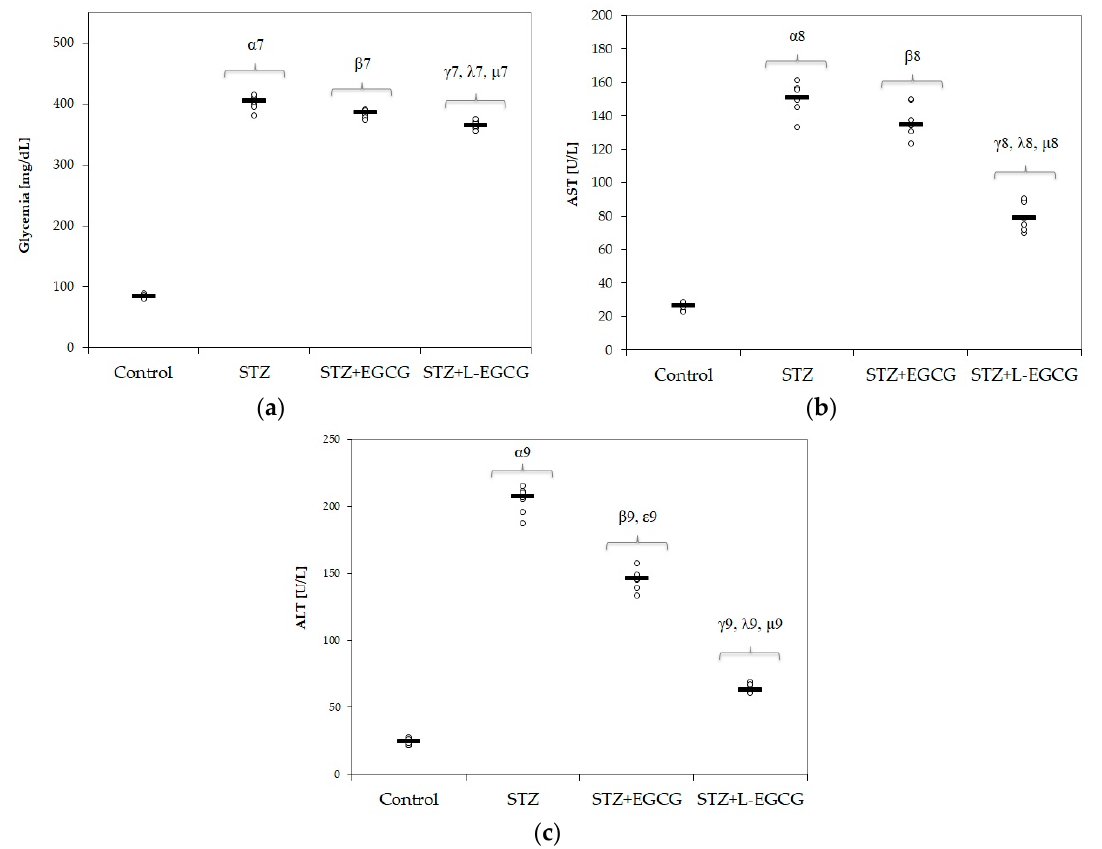
Figure 3. Distribution of ( a ) Glycemia, ( b ) AST (aspartate aminotransferase), ( c ) ALT (alanine aminotransferase) on all study groups (7 rats/group). STZ = streptozotocin control; STZ + EGCG =